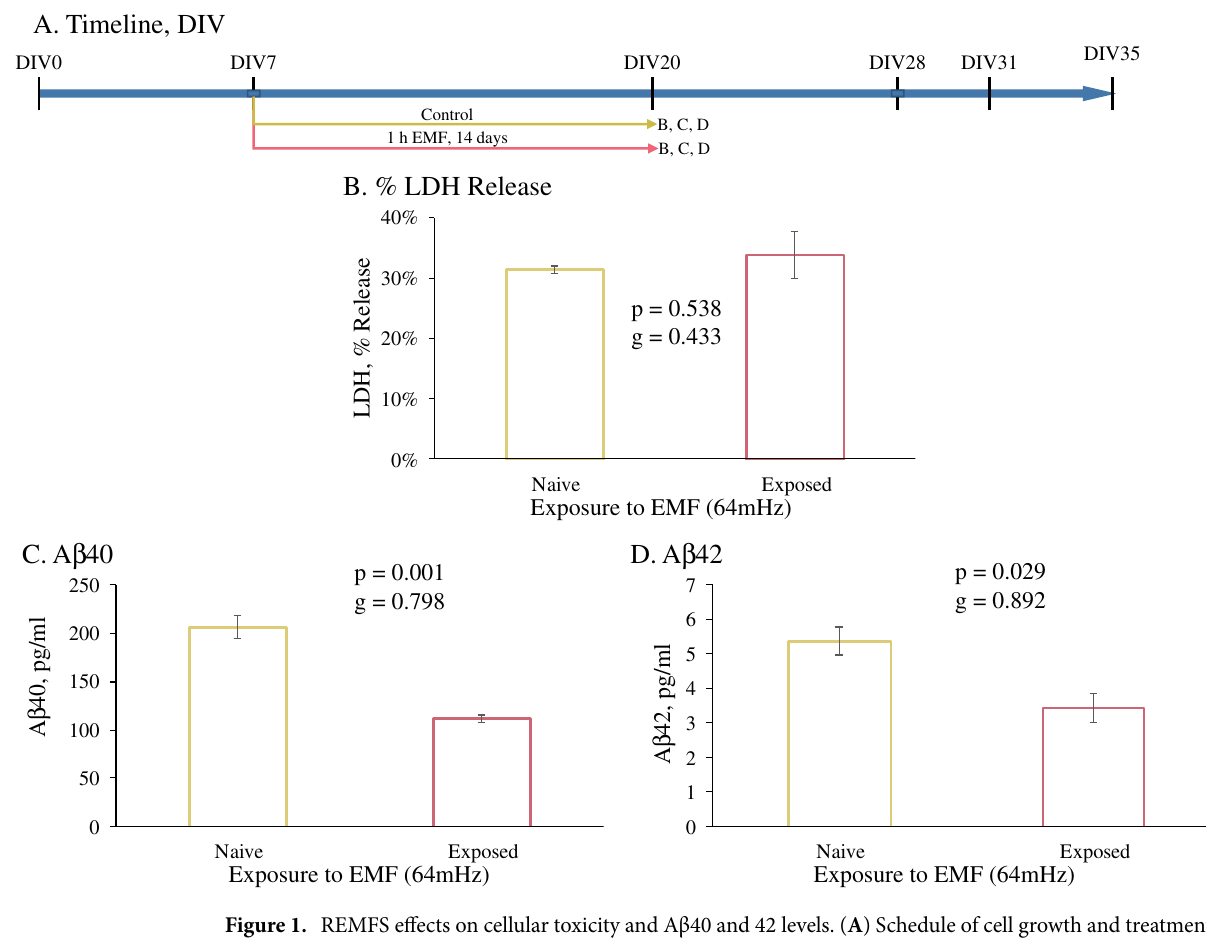
Figure 1. REMFS effects on cellular toxicity and Aβ40 and 42 levels. ( A ) Schedule of cell growth and treatments for data presented in figure. ( B ) REMFS treatment at 64 MHz with a SAR of 0.6 W/kg daily for 1 h for 14 days did not show significant cellular toxicity and/or membrane damage by LDH assay. ( C ) REMFS at 64 MHz with a SAR 0.6 W/kg daily for 1 h for 14 days reduced Aβ40 levels in PHB tissue culture conditioned media ( p = 0.001). ( D ) REMFS reduced Aβ42 levels in PHB cell culture conditioned media ( p =